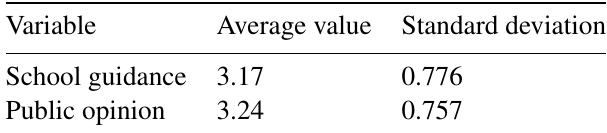
Table 8 Descriptive statistics of external environment dimensions.